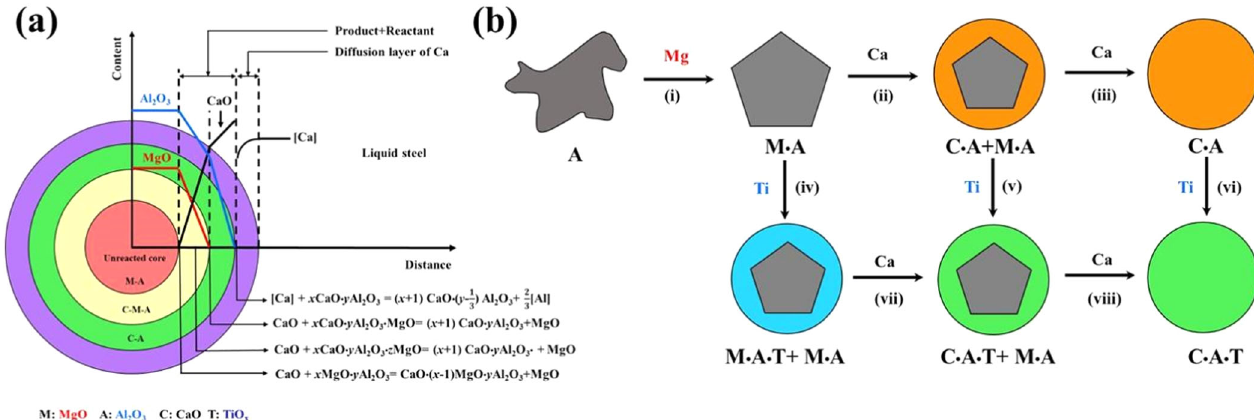
Fig. 4 Schematic diagram of the evolution of MgO-Al 2 O 3 system after adding typical elements. a Sketch of evolution of MgO-Al 2 O 3 system after adding addictive element Ca and b the illustration of modi fi cation evolution route of the MgO-Al 2 O 3 inclusion in steels with/without element Ti addition 55,56